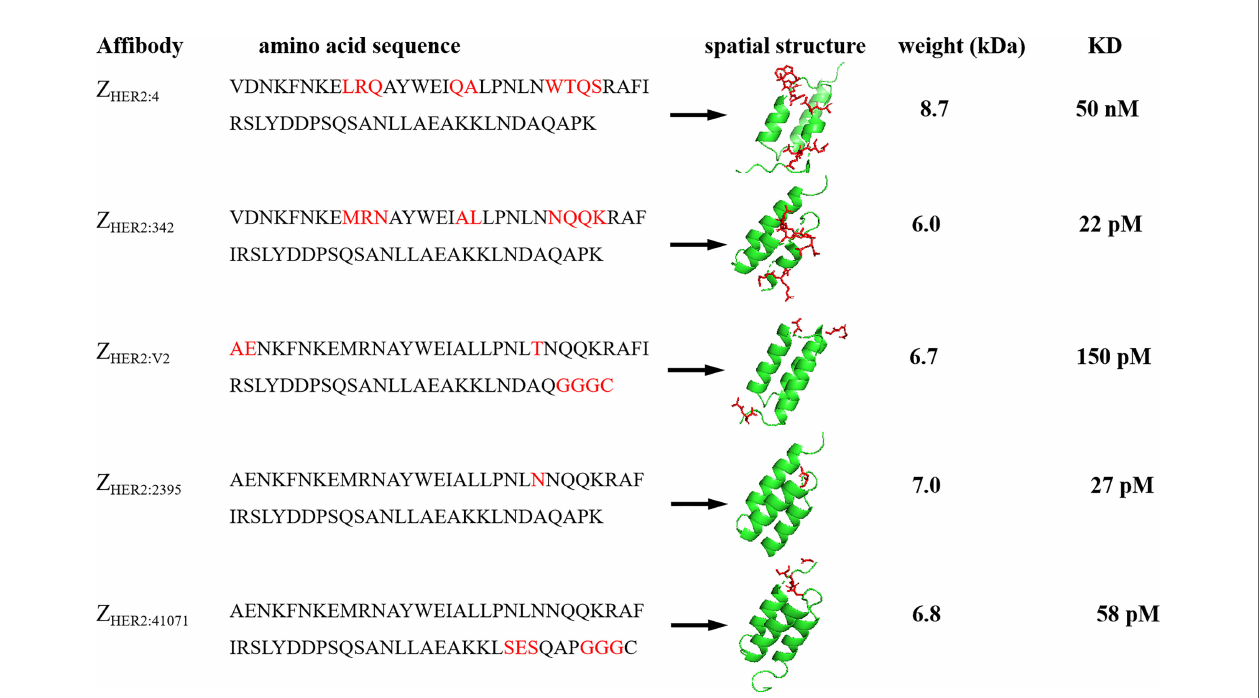
FIGURE 2 | The evolution process of af fi body. Red indicates the modi fi ed amino acid